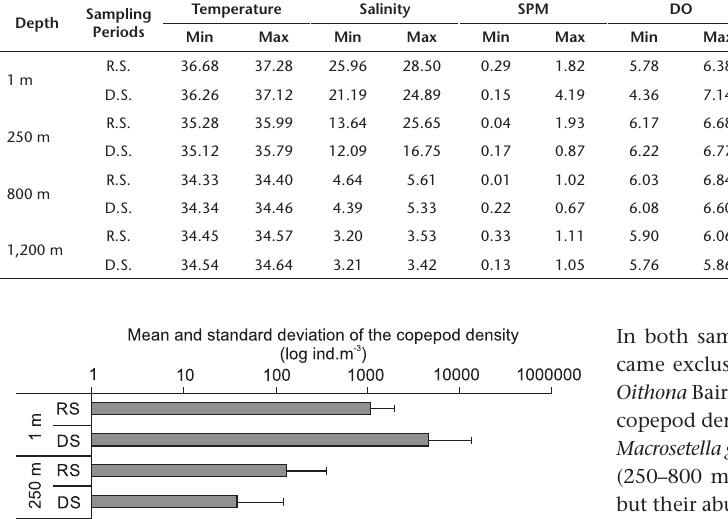
Table 1. Minimum and maximum values recorded for temperature (°C), salinity, suspended particulate matter (SPM, mg L -1 ), dissolved oxygen (DO, mg L -1 ), nitrate (μmol L -1 ), silicate (μmol L -1 ), and orthophosphate (μmol L -1 ) in samples collected in the Campos Basin water column during the rainy- and dry seasons of 2009. RS, rainy season; DS, dry season. Depth